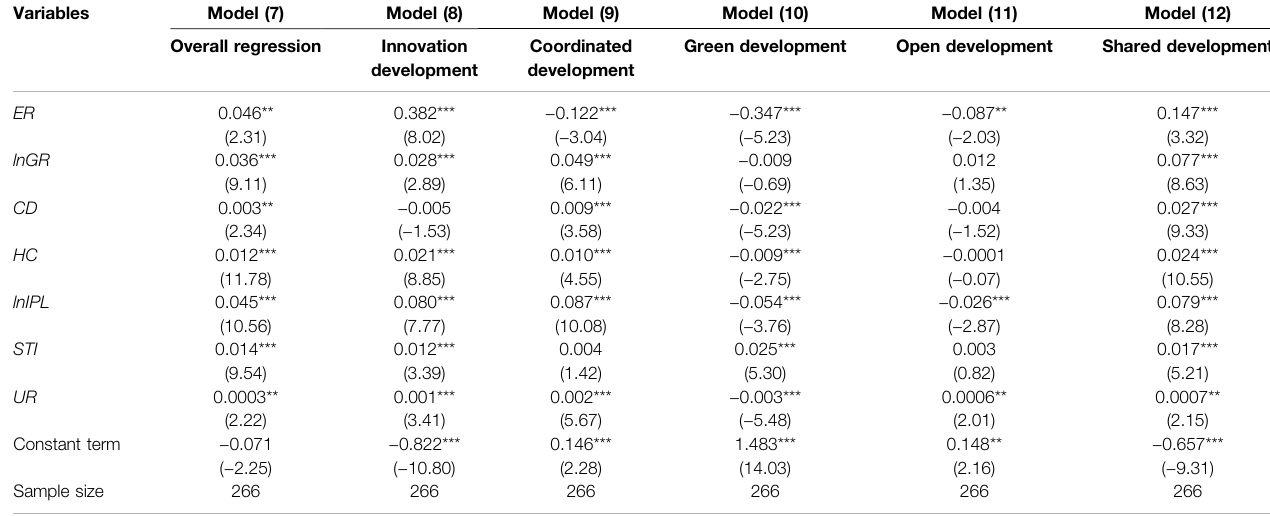
TABLE 7 | Robustness test estimates - add control variables.